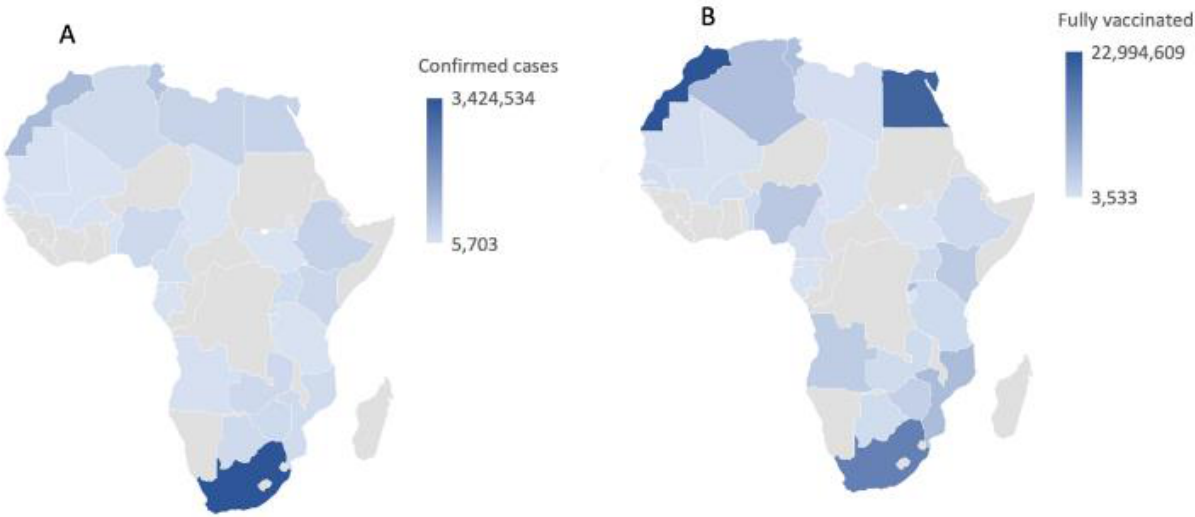
Figure 1 : A: Geographical distribution of total number of confirmed cases across the African countries randomly selected. B: Geographical distribution of the total number of fully vaccinated people across the African countries randomly selected. The maps were generated using Microsoft Excel Workbook